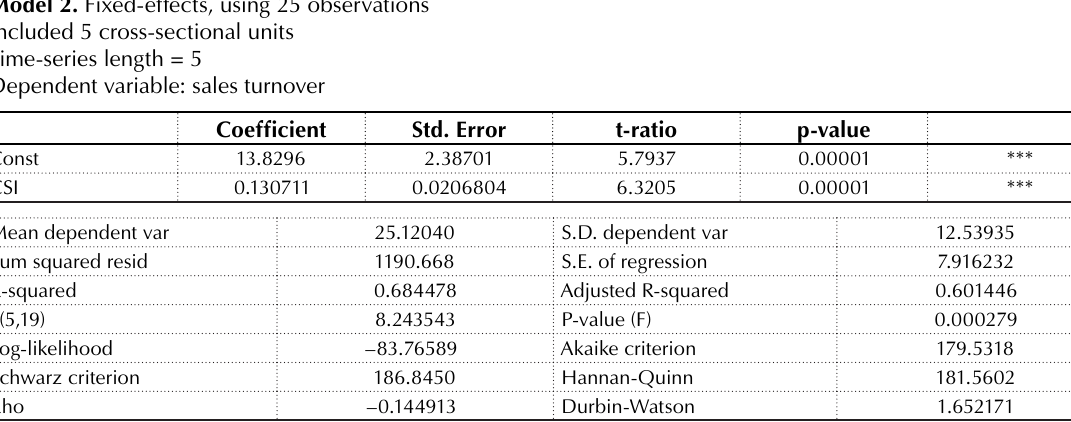
Table 2. Association between corporate social investment (CSI) and turnover Model 2. Fixed-effects, using 25 observations